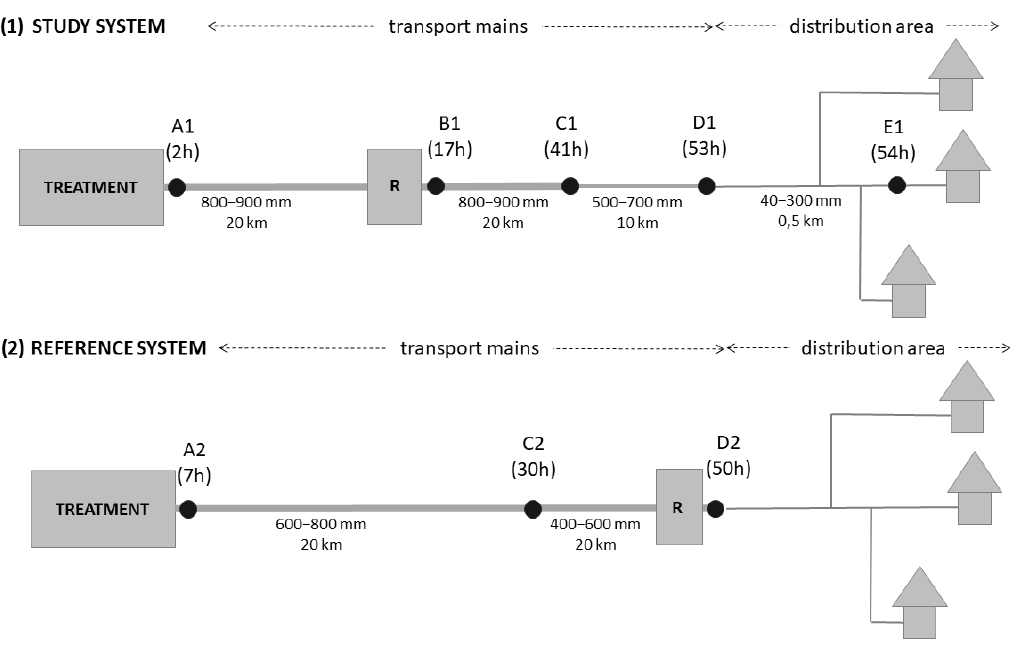
Figure 2. Sampling scheme for the study system (top) and the reference system (bottom). The sampling locations (A1 to E1 and A2 to D2) are located along known water trajectories from the treatment plants to downstream distribution areas, with intermediate storage reservoirs (R). Distances between locations, pipe diameters and residence times are indicated.